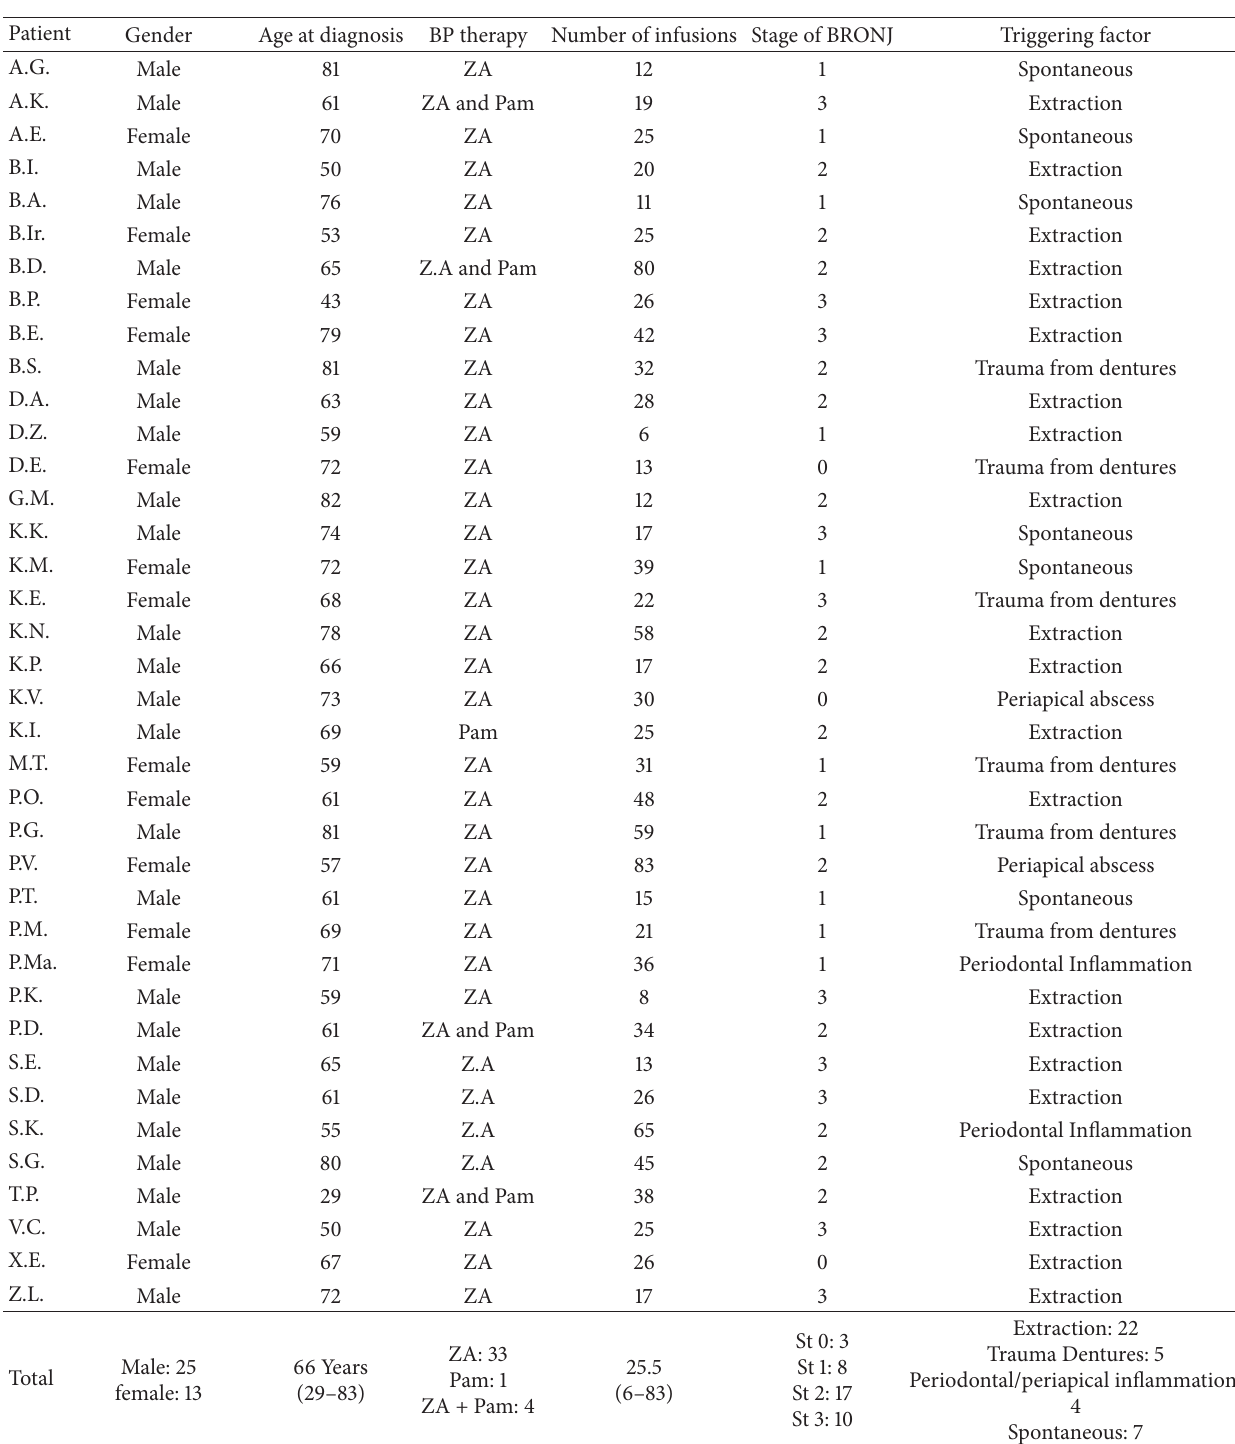
Table 1: Patients’ clinical